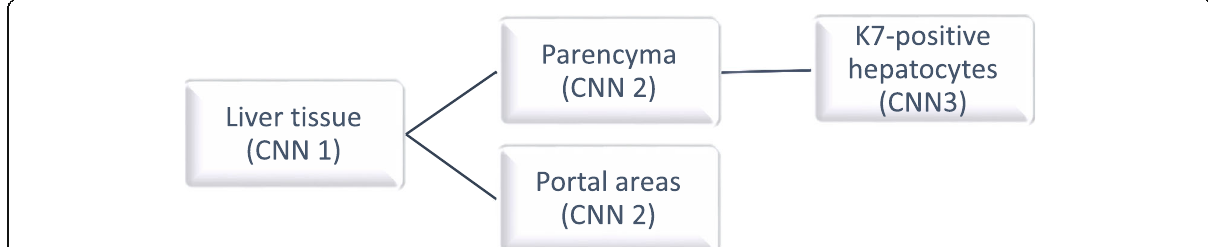
Fig. 1 The structure of the final AI model. The three independent and nested CNNs that were trained by semantic segmentation are 1) liver tissue, 2) parenchyma and portal areas and finally 3) the K7-positive hepatocytes. Ductular proliferation and original bile ducts are trained and included in the portal areas ’